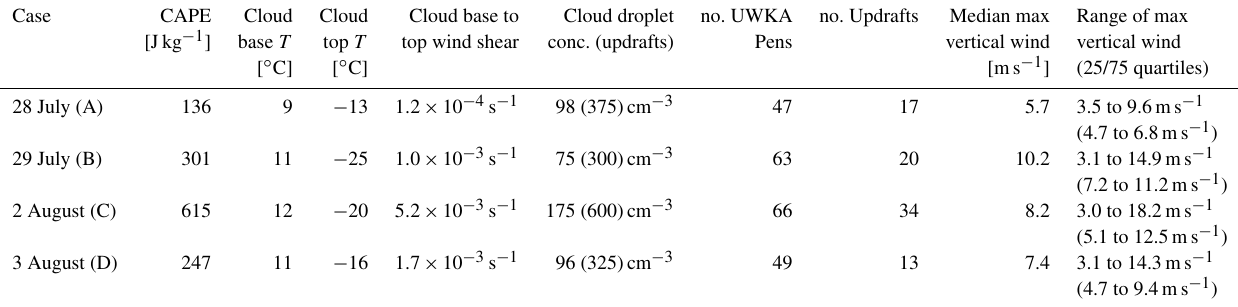
Table 1. Environmental and cloud conditions from the 4 days sampled in this study. The definition of what constitutes a penetration and updraft is provided in the